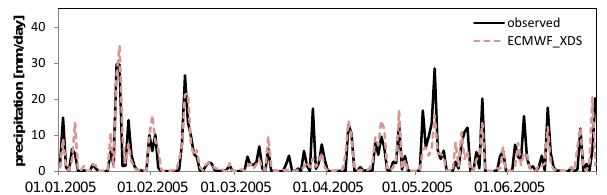
Fig. 2. Observed and statistically downscaled precipitation averaged over the entire catchment area from 1 January 2005 to 30 June 2005. The XDS model is forced using ECMWF reanalysis data (denoted by ECMWF XDS).